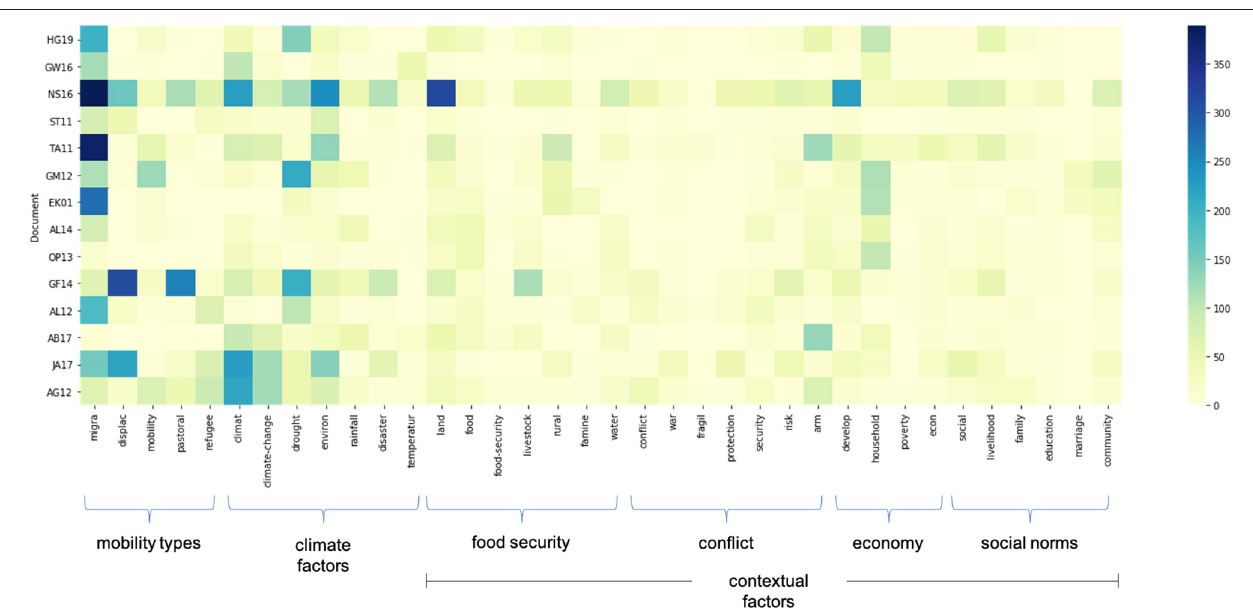
FIGURE 3 | Heatmap of word frequency illustrates the distribution of mobility types, climate, and contextual factors across the selected case studies. Contextual factors include four topics: conflict, economy, food security, and social norms. Each topic consists of five to eight keywords derived from a list of the 100 most frequent